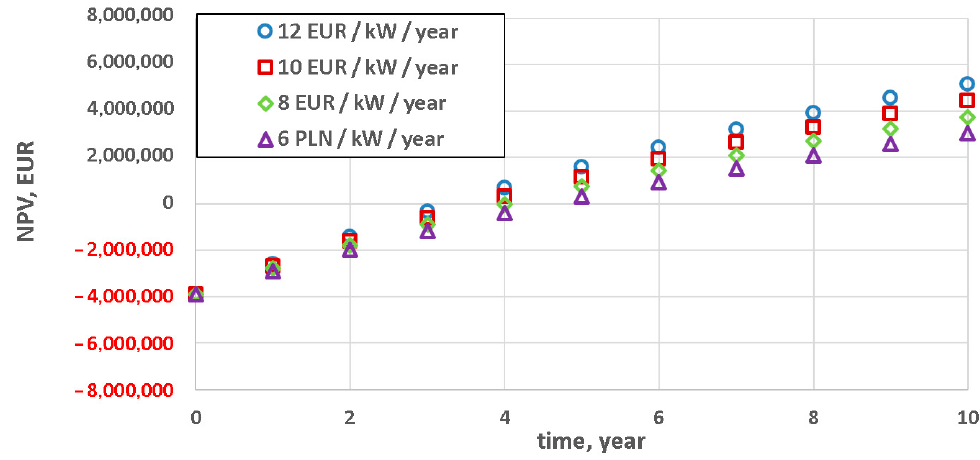
Figure 9. Results of NPV analysis for different prices of 1 kW/year on the capacity market (for technical minimum amounting to 30% of the rated power, Y = 1, r = 9%).